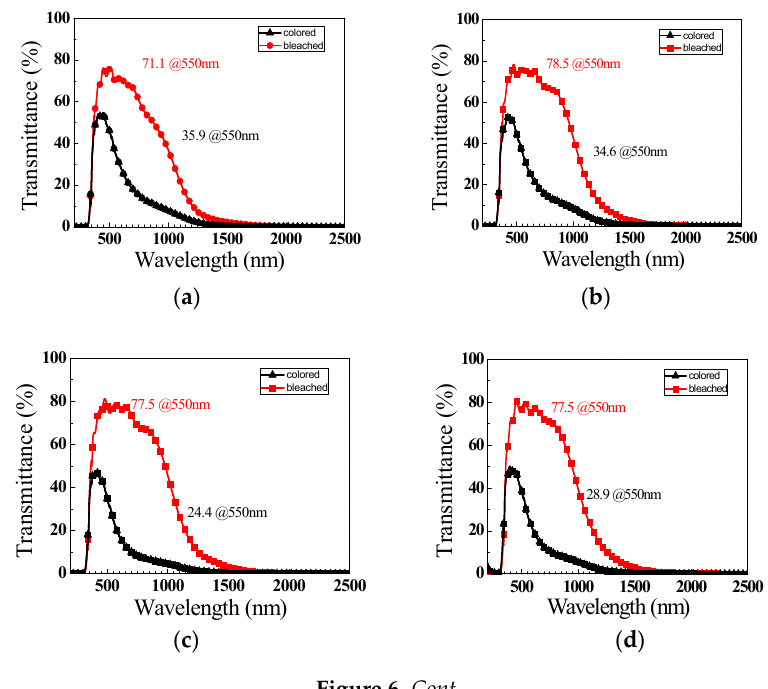
3 ; ( b ) LW1; ( c ) LW2; ( d ) LW3. Figure 5. Cyclic voltammetry of electrochromic devices (ECDs): ( a ) WO